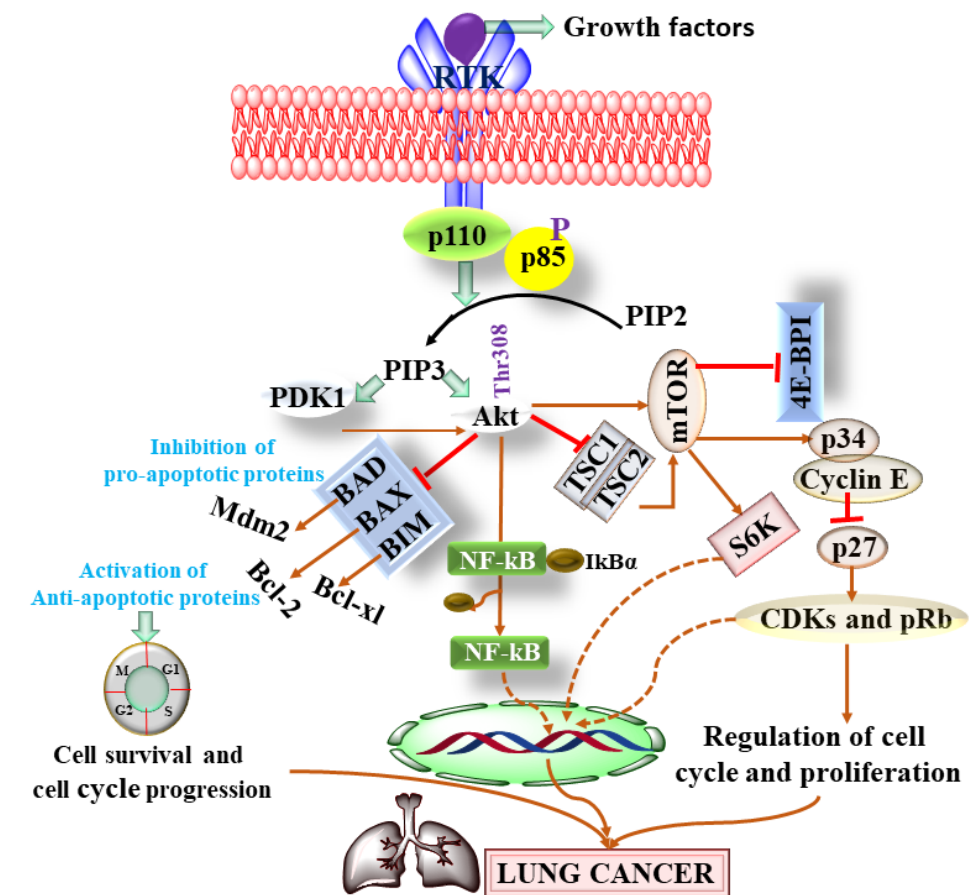
Figure 3. Showing the role of PI3K/Akt pathway in lung cancer. Pyruvate dehydrogenase kinases (PDKs), Phosphatidyl- inositol 4,5-bisphosphate (PIP), mammalian target of rapamycin (mTOR), eukaryotic translation initiation factor 4E-bind- ing protein 1 (4E-BP1), TSC Complex Subunit 1 (TSC1), cyclin-dependent kinase (CDK), pRB (retinoblastoma protein), mouse double minute 2 (Mdm2), nuclear factor kappa-light-chain-enhancer of activated B cells (NF-kB) and nuclear factor of kappa light polypeptide gene enhancer in B-cells inhibitor, alpha (IKB α